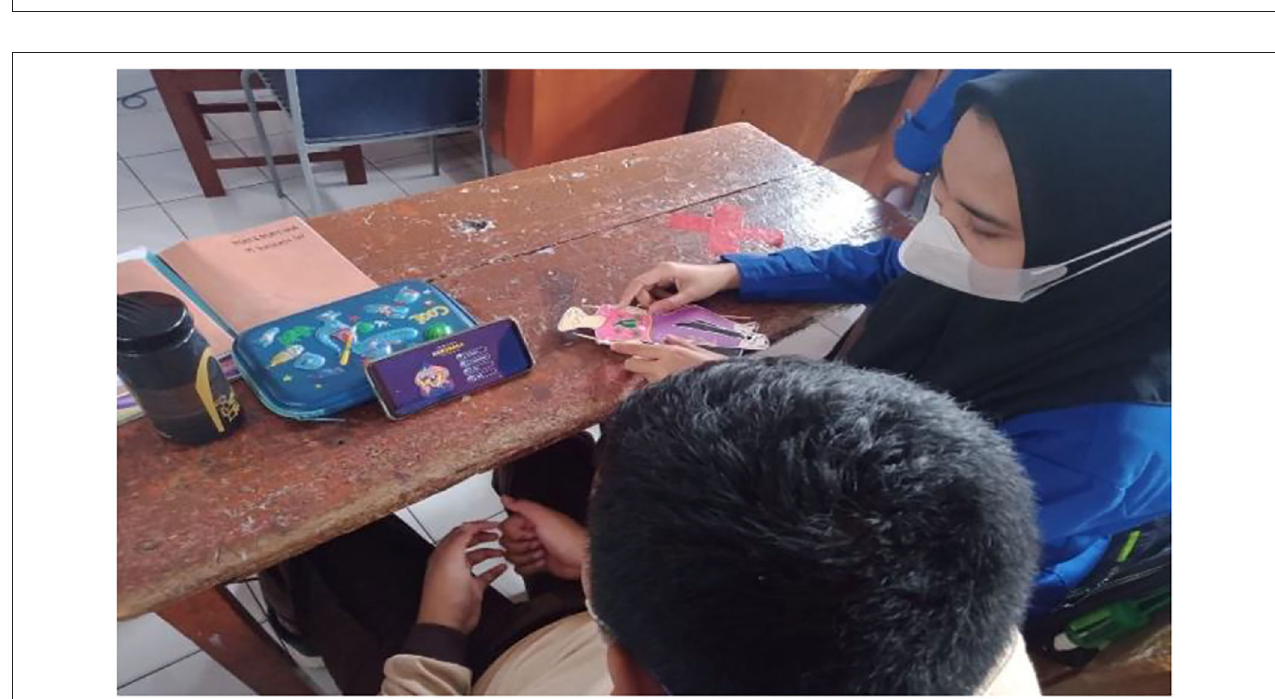
FIGURE 4 | Learning activities using the Puppet Sukuraga